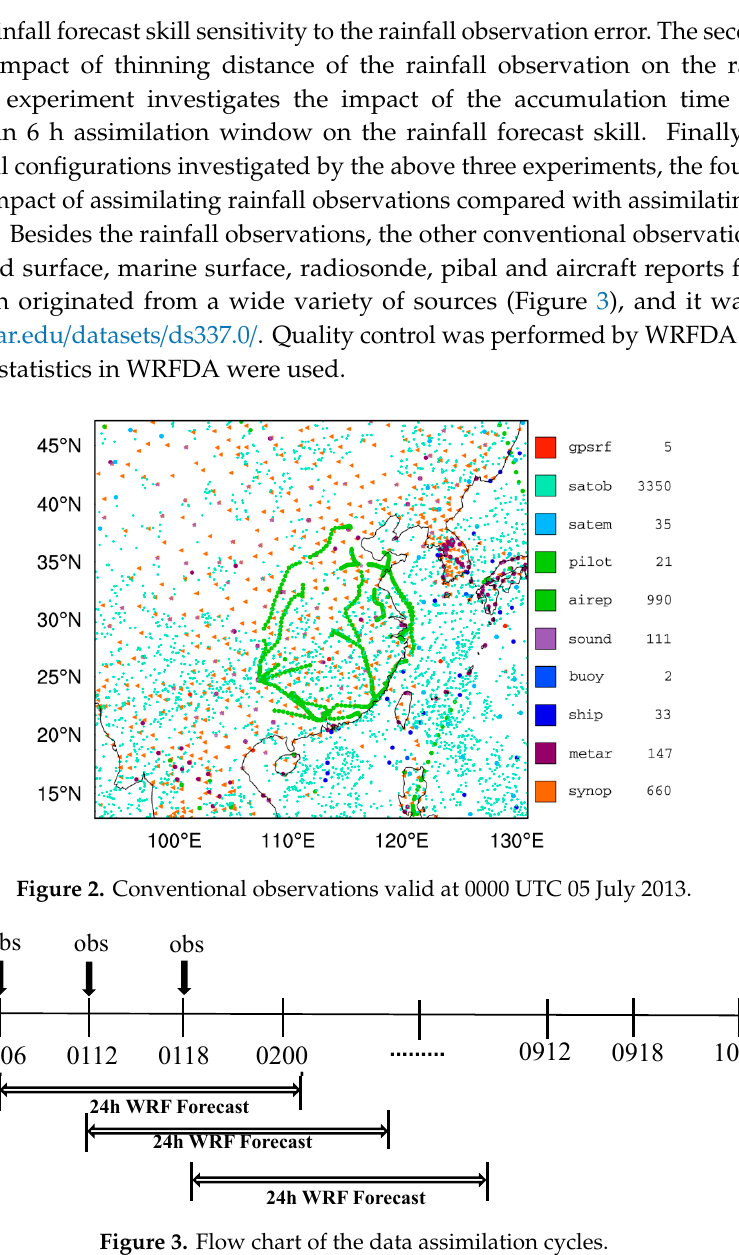
Figure 3. Flow chart of the data assimilation cycles.